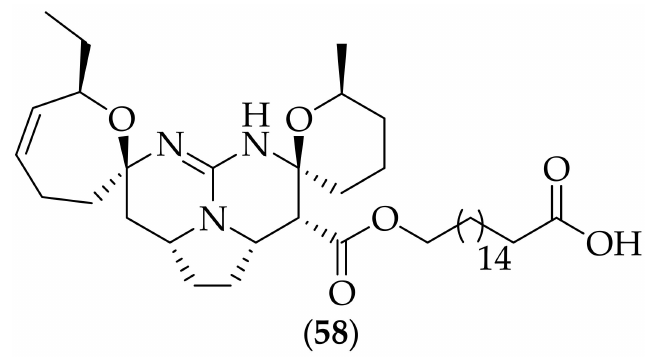
Figure 39. Structure of crambescidic acid-671 ( 58